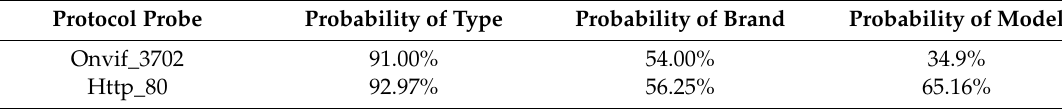
Table 3. The device attributes identification of Onvif and Http